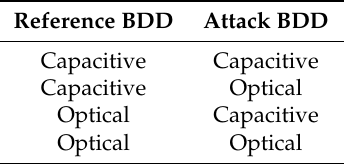
Table 1. Example of scenario 2 for the sensor type.